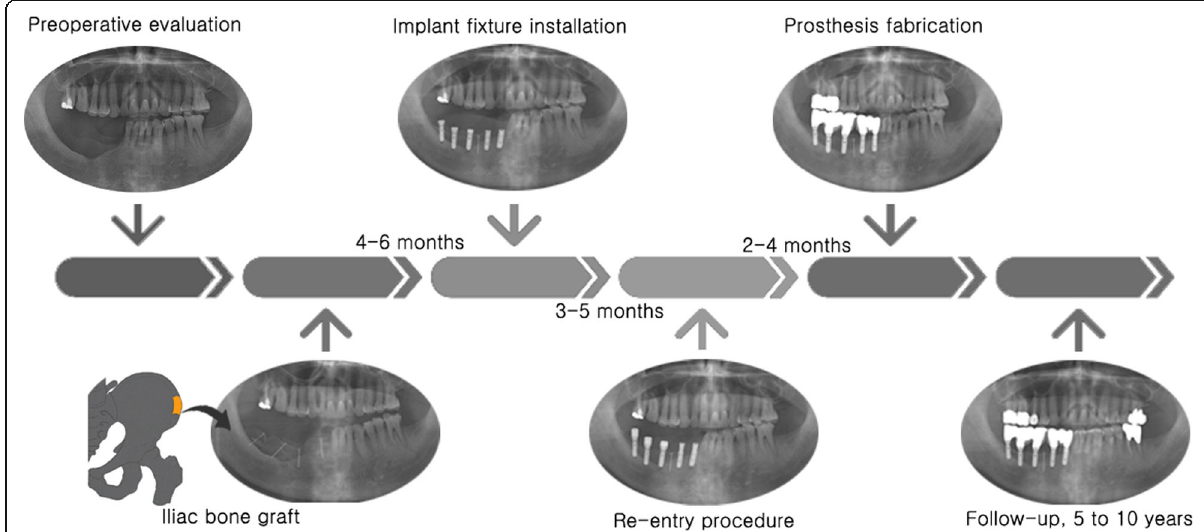
Fig. 1 Schematic representation of the treatment protocol for iliac bone grafting and implant installation, including bone block harvesting from the iliac crest on lower left drawing